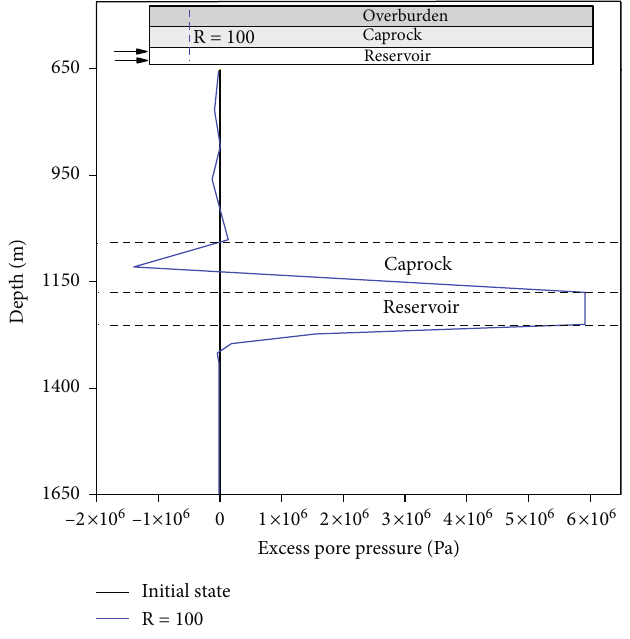
Figure 14: The excess pore pressure curve of the vertical survey